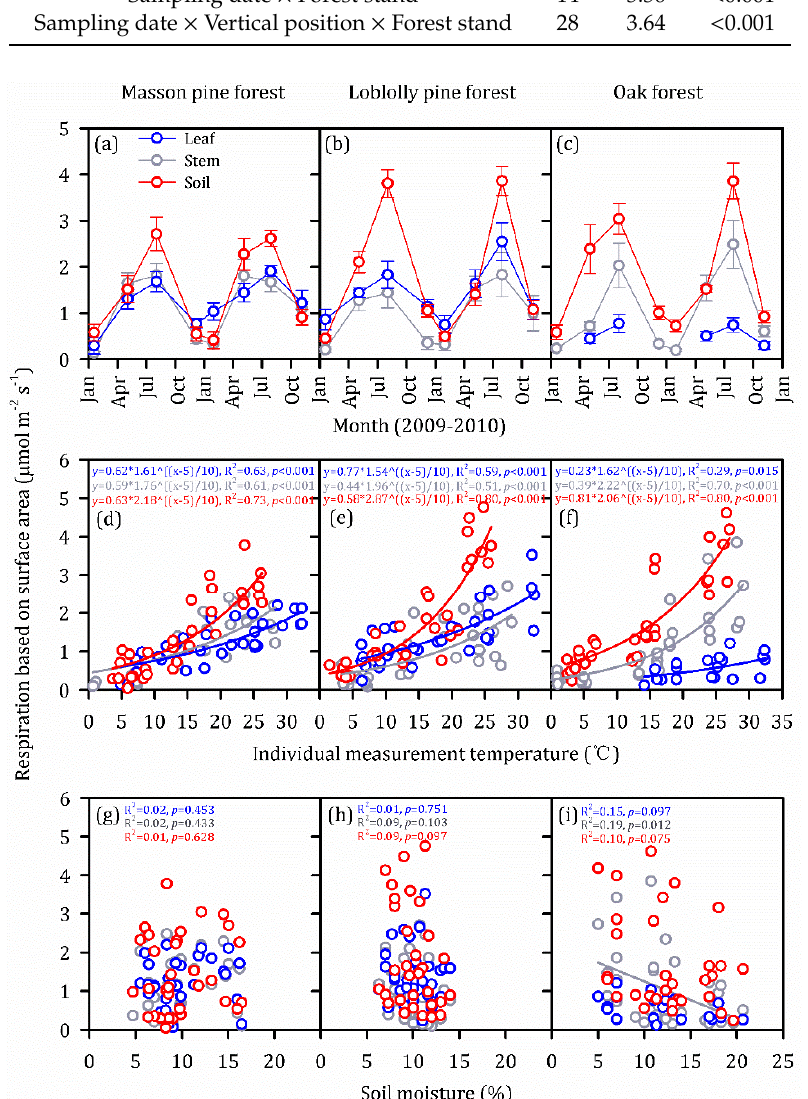
Figure 3. Seasonal variations (top panels), temperature dependence (middle panels), and soil moisture dependence (bottom panels) in individual components, including leaf respiration (blue), stem respiration (grey) and soil respiration (red), of ecosystem respiration (ER) for masson pine ( a , d , g ), loblolly pine ( b , e , h ) and oak ( c , f , i ) forests over a 2 year period. Values are means ± SE ( n = 4). Leaf respiration of oak forest was not measured in January and December 2009 and January 2010 because oaks are